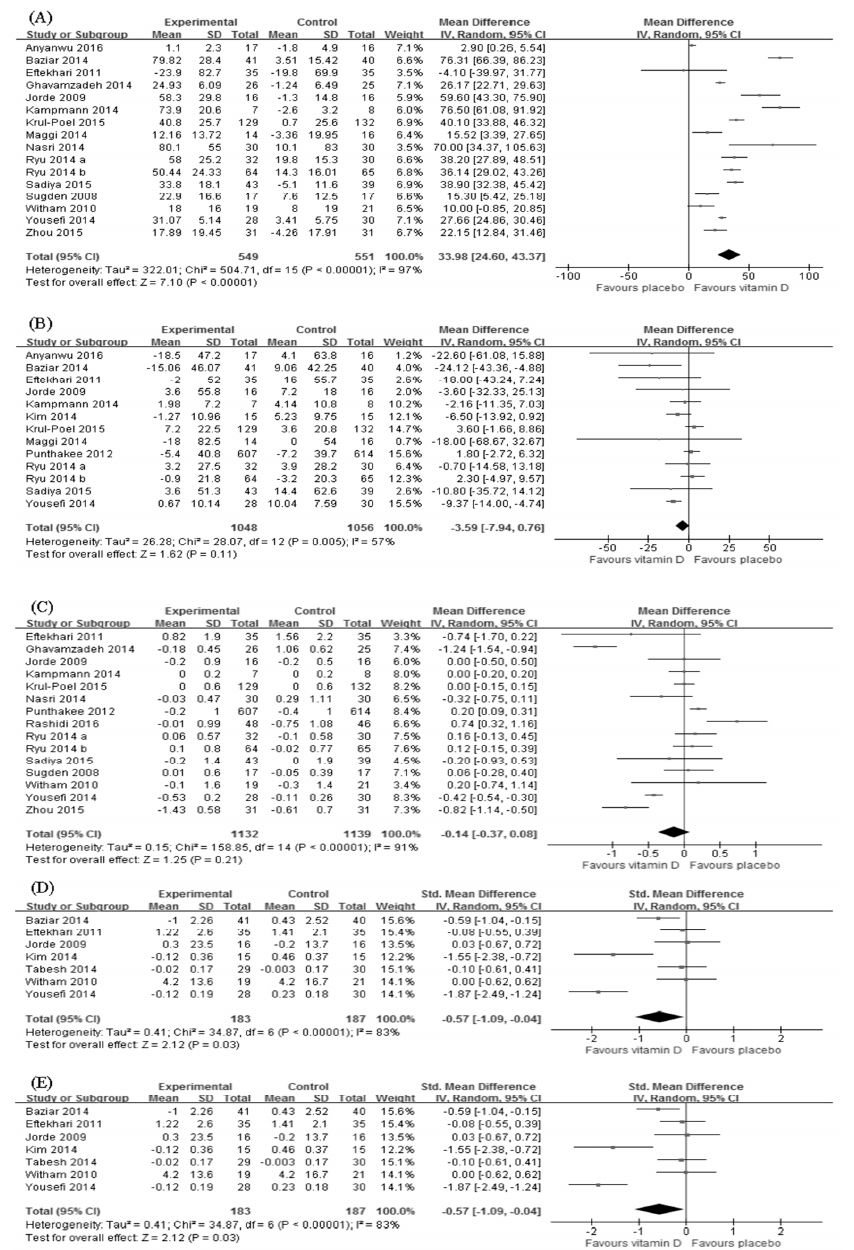
Figure 3. Effect of vitamin D supplementation on ( A ) serum vitamin D level; ( B ) fasting blood glucose; ( C ) hemoglobin A1c; ( D ) homeostasis model assessment of insulin resistance and ( E ) fasting insulin. (The size of box represents the weight of each study, and the lateral tips of diamond shows the confidence interval of the pooled result.)